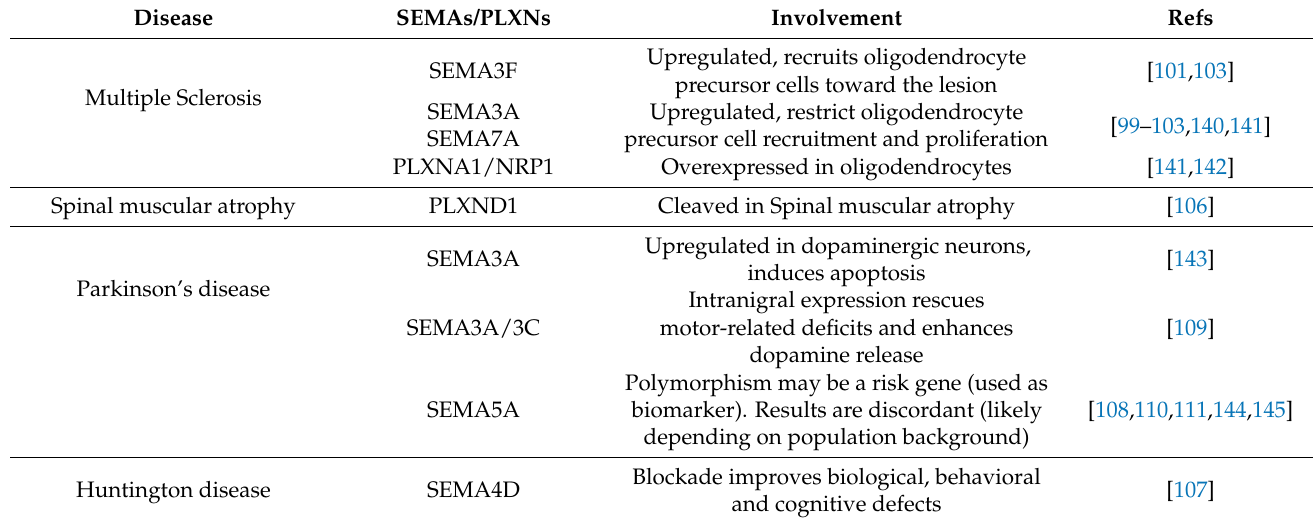
Table 1. Summary of known Semaphorin (SEMA) and Plexin (PLXN) contributions to neurodegenerative disease patho- physiology and development. Note that the focus here is brought to dysregulations found in the brain. Other Semaphorins and Plexins in immune cells are found and likely contribute to neuroinflammatory characteristics of these diseases.